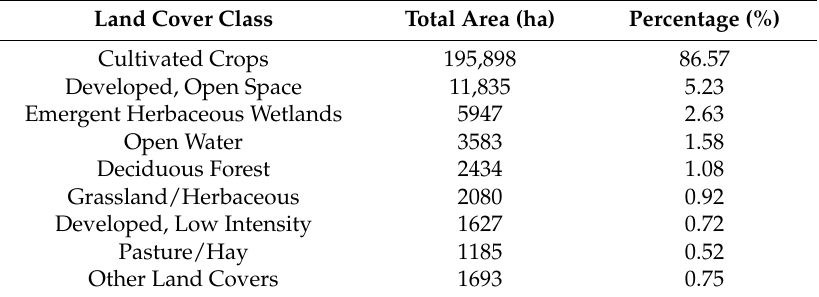
Table 1. 2011 National Land Cover Data (NLCD) statistic for the Watonwan